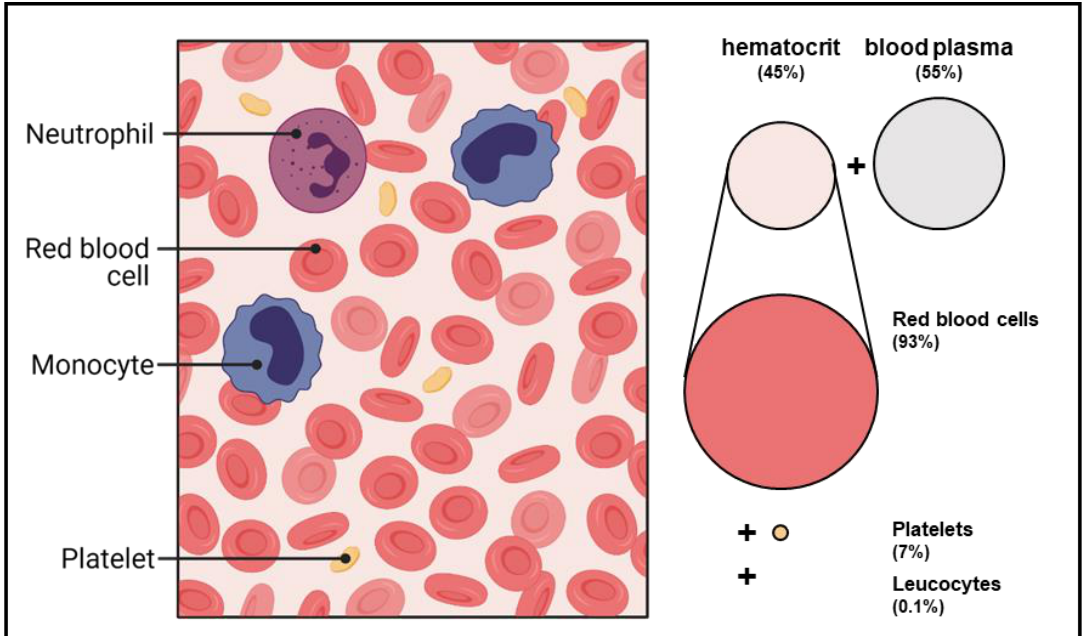
Figure 1. Blood and compartments, including segmentation of the hematocrit across weight- correlated abundancies of erythrocytes, thrombocytes, and leukocytes. Created with biorender.com (accessed 01/02/22).